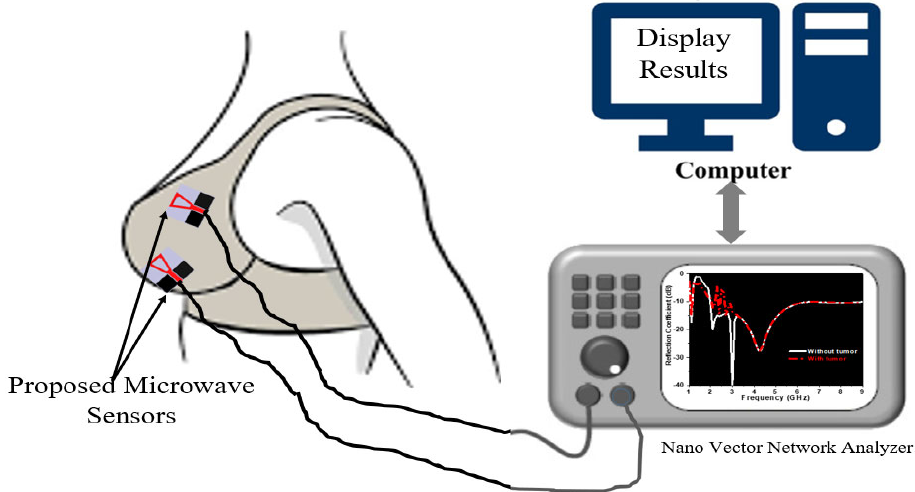
Figure 1, Proposed Smart Bra for breast cancer monitoring detection. Figure 1. Proposed Smart Bra for breast cancer monitoring